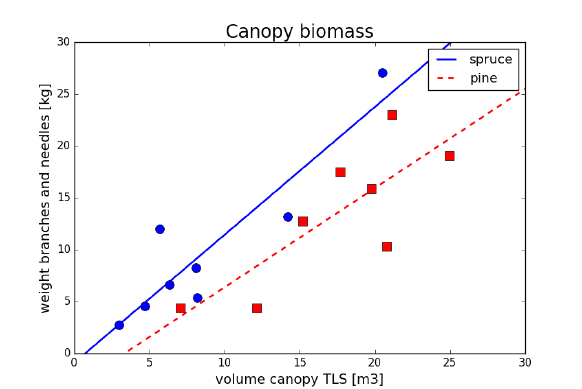
Figure 5. A linear model of stem biomass using TLS estimated volume as independent variable.